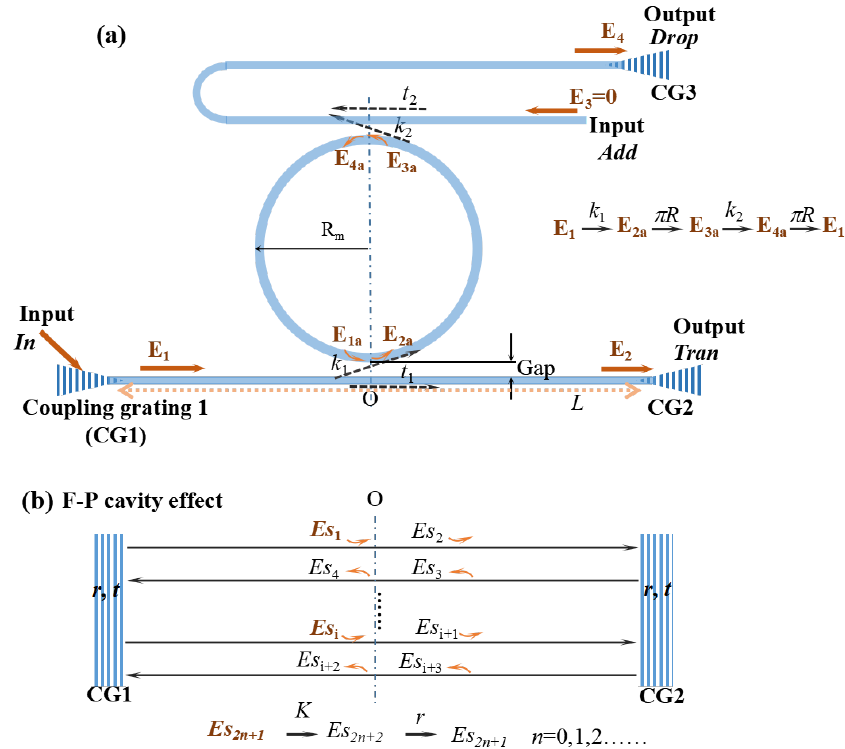
Figure 1. ( a ) An add-drop MRR schematic diagram. CG1 and CG2 are the coupling grating s . In is the optical signal input port; Tran is the direct output port; Drop is the download port; Add is the load port. The spacing between looped optical waveguide and straight optical waveguide is Gap , and the length of straight waveguide is L . ( b ) Optical transmission schematic diagram based on waveguide F-P cavity. Es 1 , Es 2 … Es n are optical amplitude at different stages. r and t are the reflection coefficient and transmission coefficient of grating coupler interface, respectively.